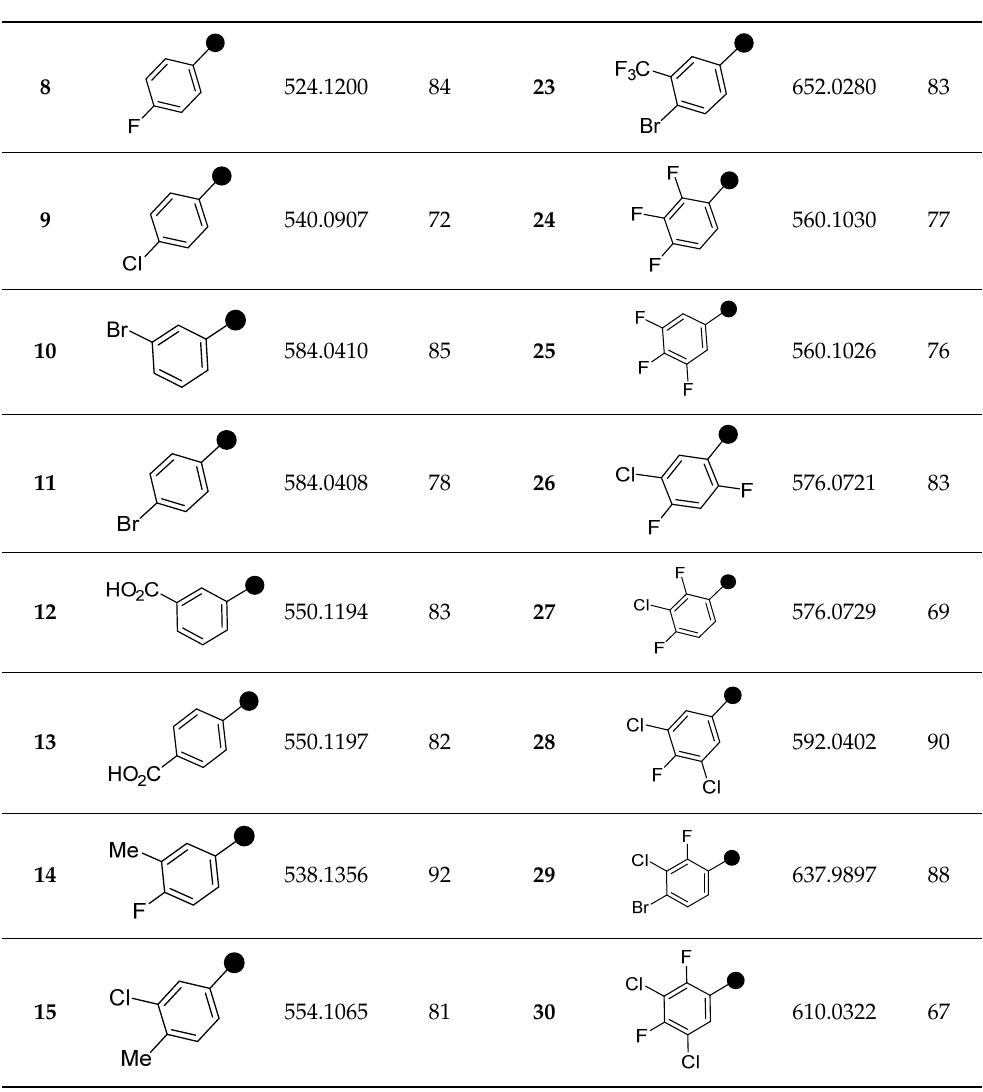
Molecules 2021 , 26 , x FOR PEER REVIEW